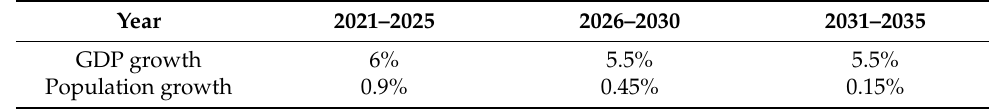
Table 2. Population and investment growth rate settings in Guangdong